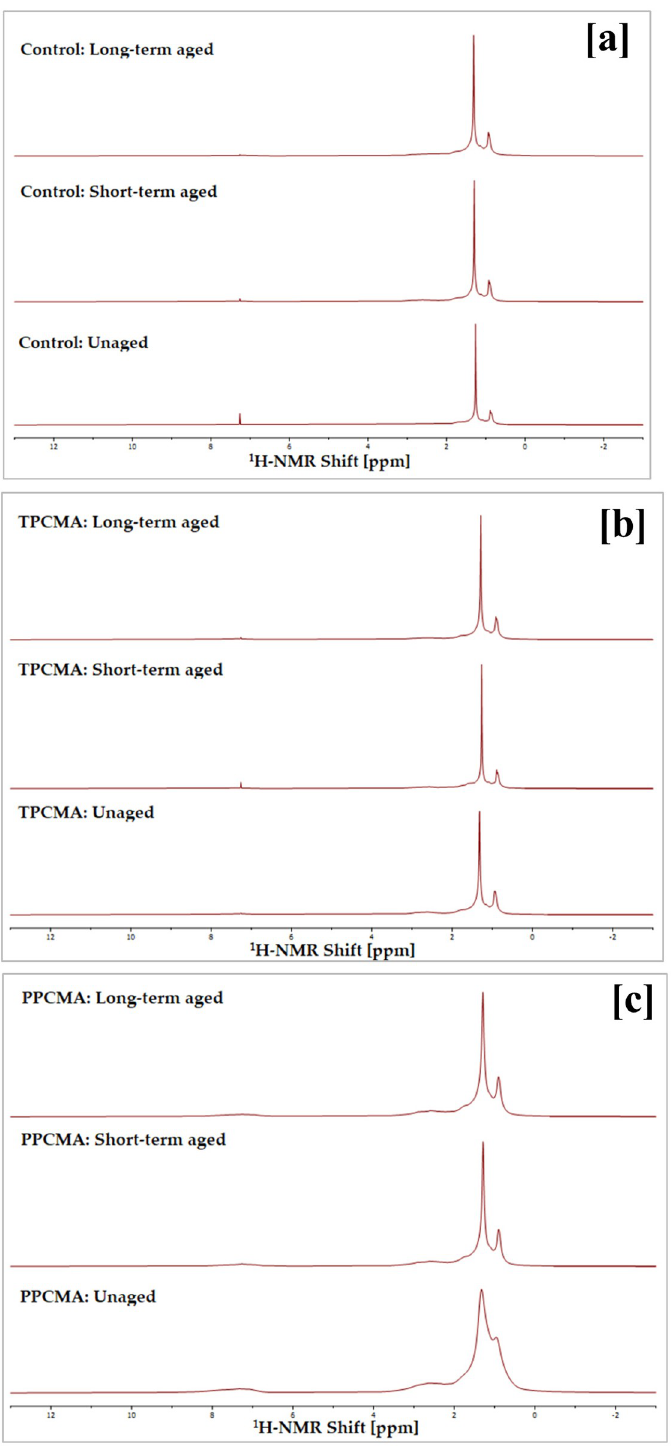
Fig 15. 1 H-NMR spectra under different aging states (a) Control (b) TPCMA (c) PPCMA.